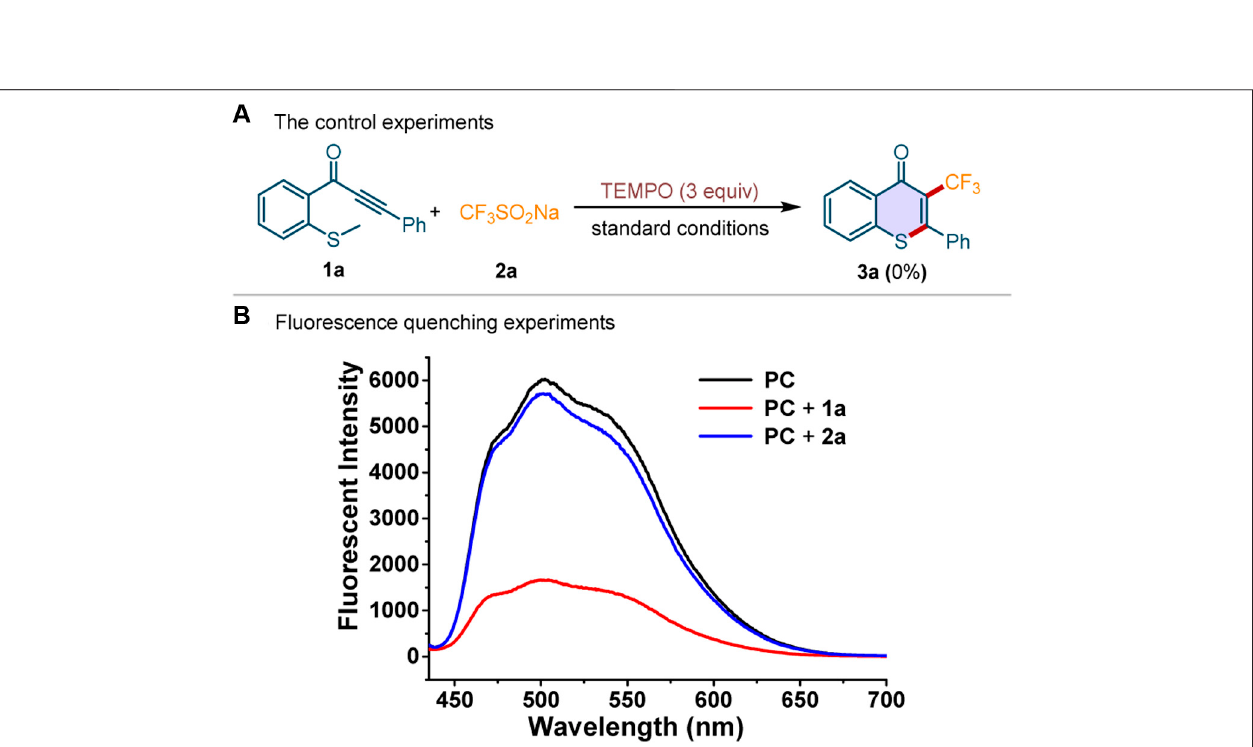
Scheme 5 | The control experiment and fl uorescence quenching experiment.